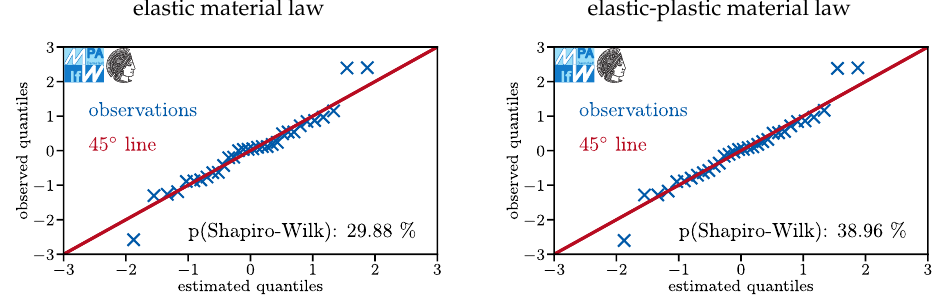
Figure A11. Quantile-quantile plots for 50CrMo4 specimens in laboratory air; 1096MPa ultimate tensile strength; K t = 1.2.